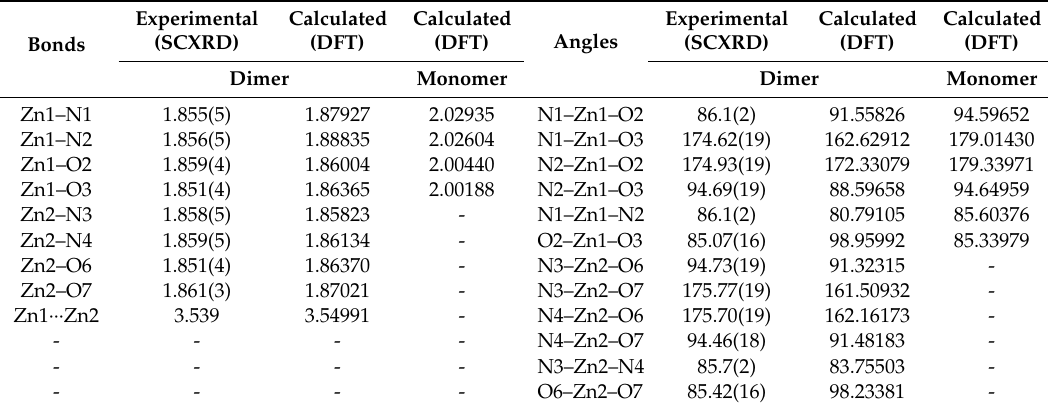
Figure 3. The single crystal X − ray structure of [Zn(sal)](H 2 O) complex. ( A ) Monomer, ( B ) dimer (top view), and ( C ) dimer (side view), along with labeling of atoms. Thermal ellipsoids were shown at 50% probability. Hydrogen atoms and solvate H 2 O molecules have been omitted for clarity. Table 2. Geometric parameters of selective experimental (single crystal X-ray diffraction, SCXRD) and calculated (DFT) values of bond distances (Å) and bond angles (°) for [Zn(sal)](H 2 O) complex.